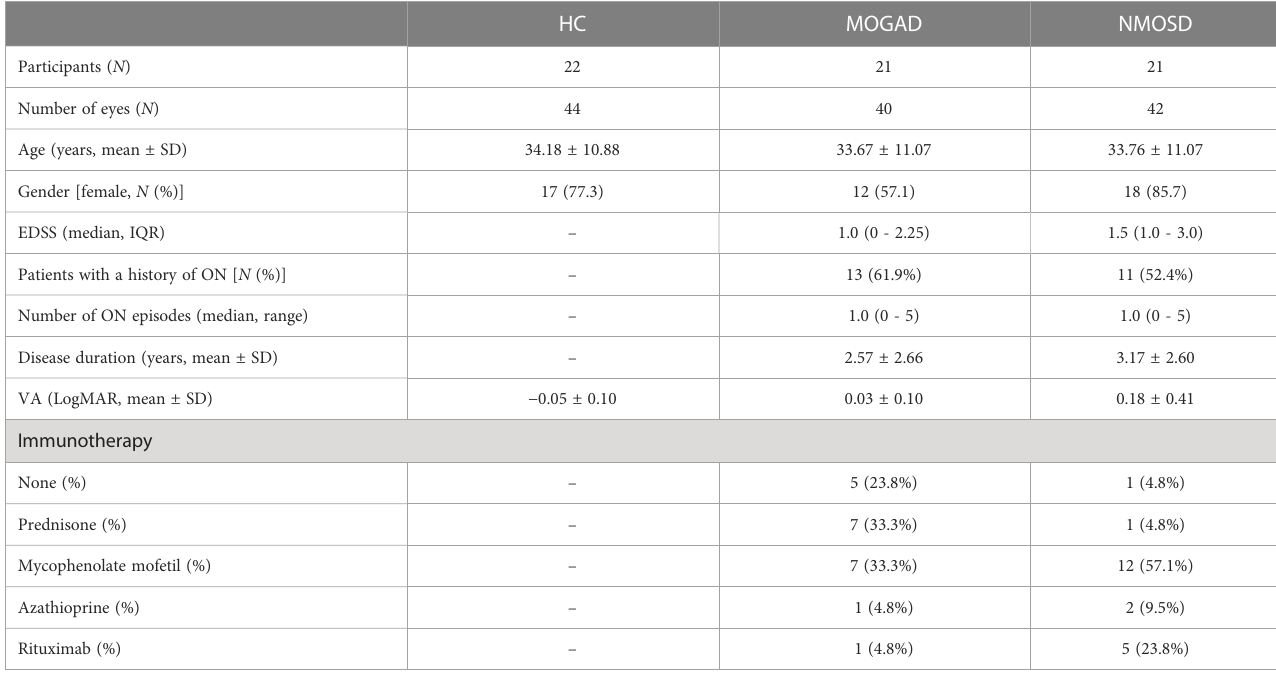
TABLE 1 Demographic